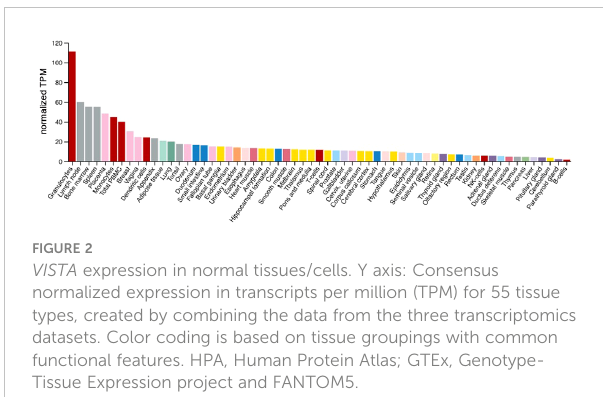
FIGURE 2 VISTA expression in normal tissues/cells. Y axis: Consensus normalized expression in transcripts per million (TPM) for 55 tissue types, created by combining the data from the three transcriptomics datasets. Color coding is based on tissue groupings with common functional features. HPA, Human Protein Atlas; GTEx, Genotype- Tissue Expression project and